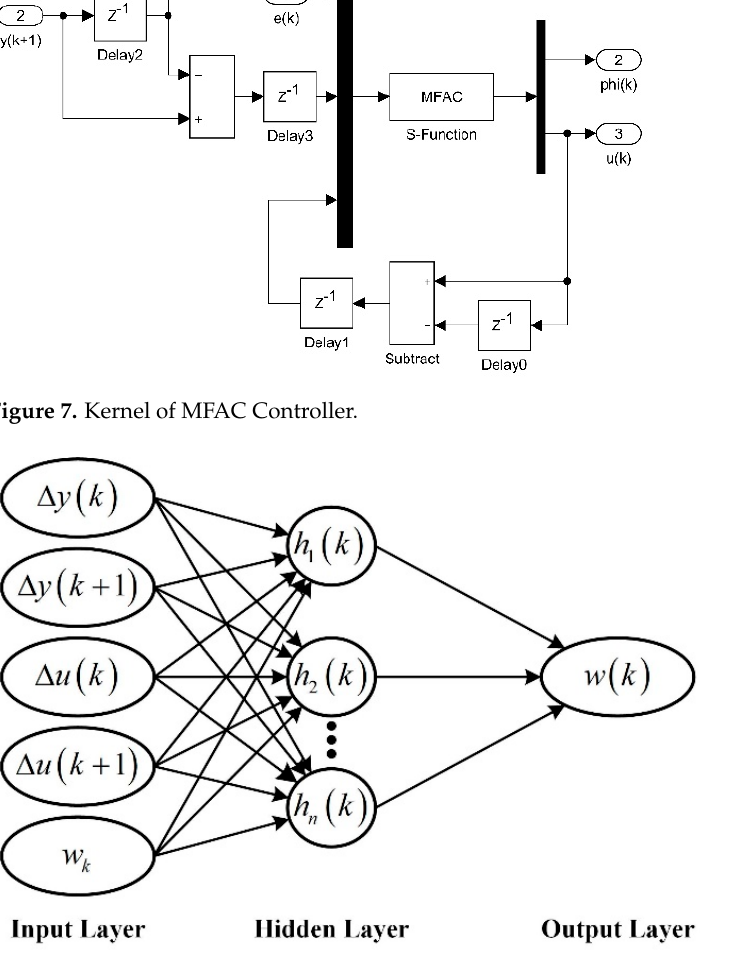
Figure 8. Topology Structure of RBFNN.